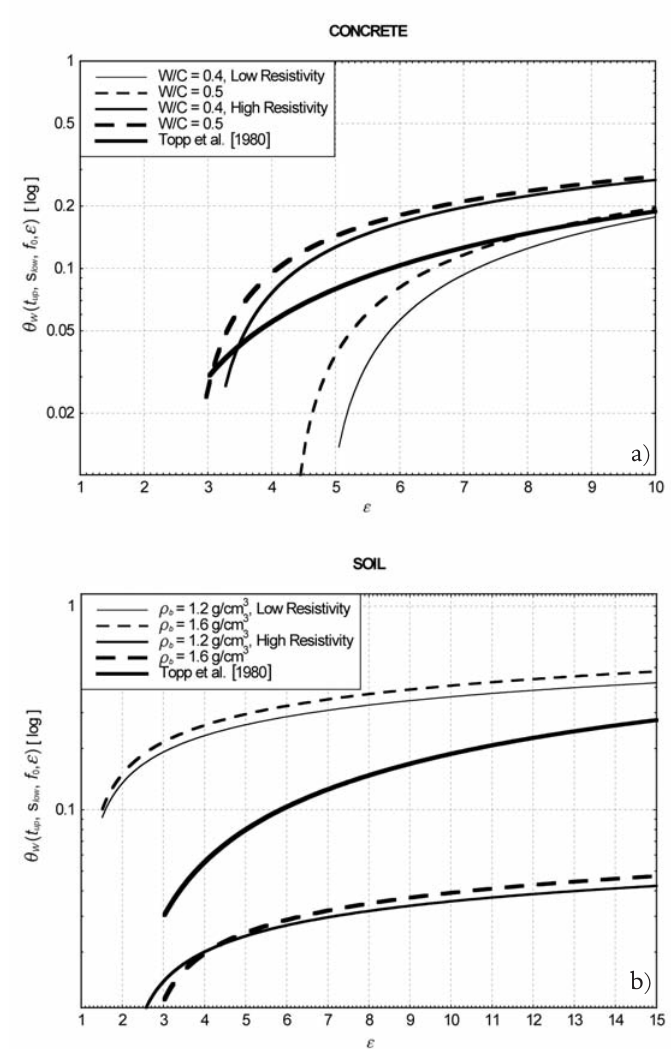
Figure 2. Operating conditions are described in the caption of Figure 1. Concrete (a) and terrestrial soil (b) are characterized by high temperature ( t = 29 ºC) and low salinity ( s up theoretical model with the Topp et al. [1980] empirical law. Semi- logarithmic plots for the volumetric content i function of relative dielectric permittivity f , for both the concrete and soil (Table 1). Table 1. Operating conditions described in the captions of Figures 1 and 2. The theory: modeling water content i relative dielectric permittivity f is always valid for all the concrete samples and holds up to a reasonable limit i textured terrestrial soil varieties, with low or high electrical